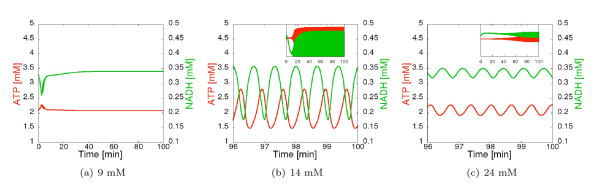
Simulated time courses of [ATP] and [NADH] in the three different dynamic regimes at concentrations of [Glcx]0 from time t = 0 min to t = 100 min. In Figure (b), (c) the subinterval from t = 96 min is drawn to a larger scale.